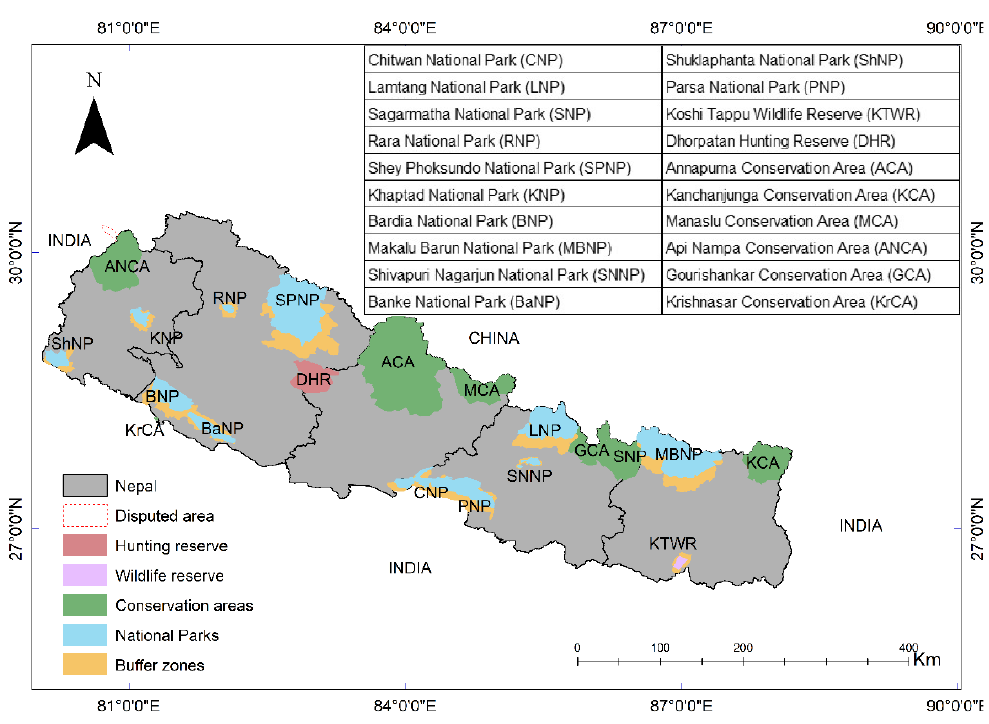
Figure 1. Nepal’s PAs [76].